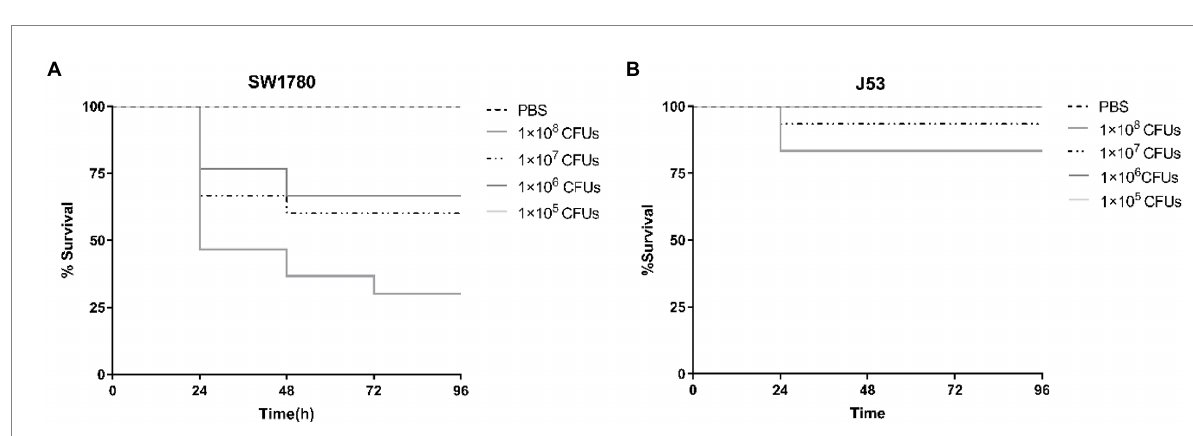
FIGURE 3 Survival of larval larvae infected with strains K . pneumoniae SW1780 (A) and E . coli J53 (B)